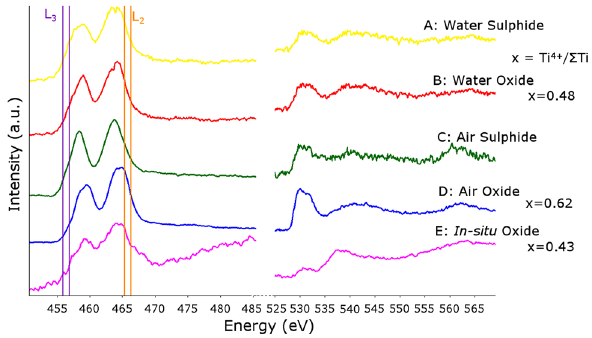
Fig. 5 Comparison of Ti and O EELS edges from across different sample of oxidised TiS 2 . a From the sulphide region of the water oxidised fl ake in Fig. 2, b from the oxide region of the water oxidised fl ake in Fig. 2, c from the sulphide region of the air oxidised fl ake in Fig. 3, d from the oxide region of the air oxidised fl ake in Fig. 3, e from the oxide region of the in situ oxidised fl ake in Fig. 4. Inset concentration of Ti 4+ within oxide